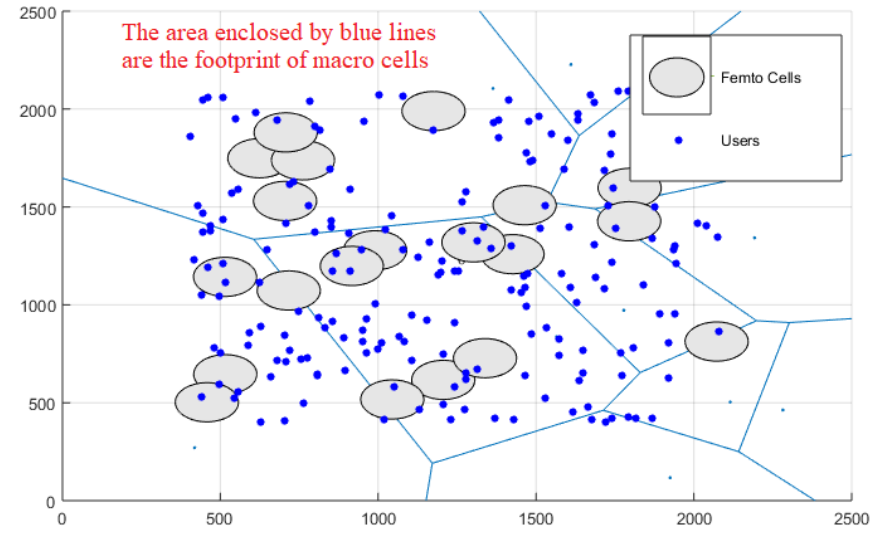
Figure 8. Simulation model of a heterogeneous